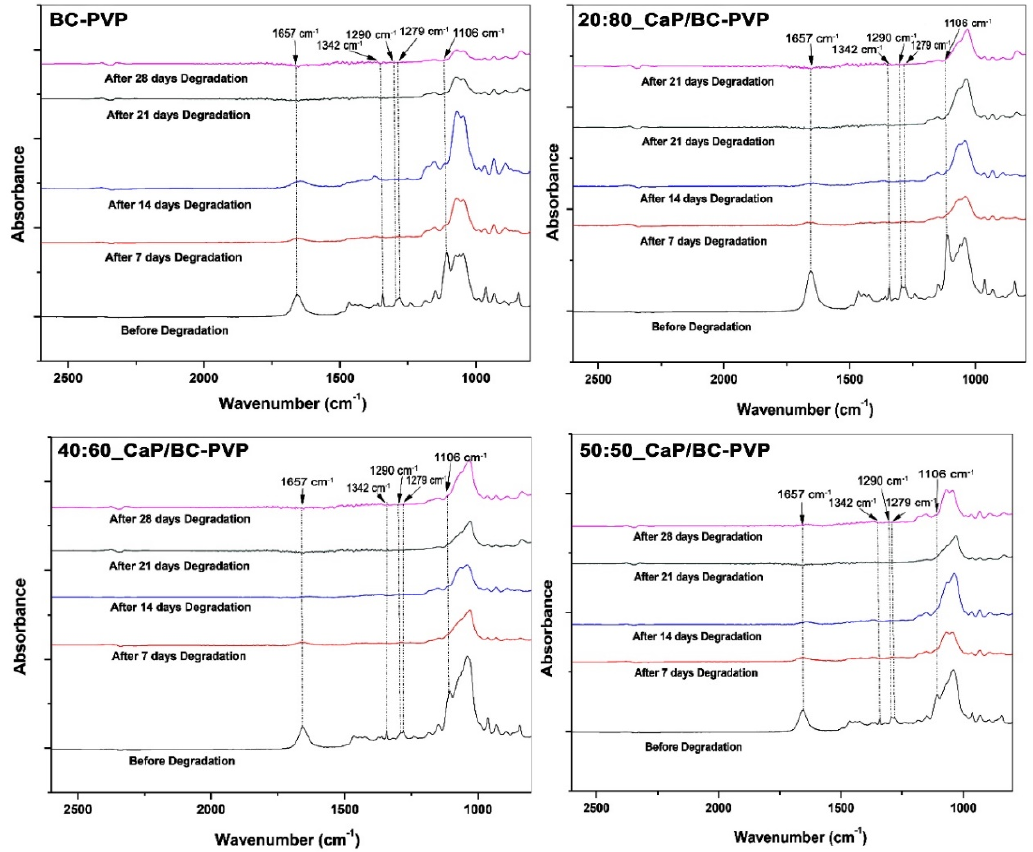
Figure 5. FTIR analysis of calcium phosphate incorporated BC based hydrogel scaffolds (i.e.